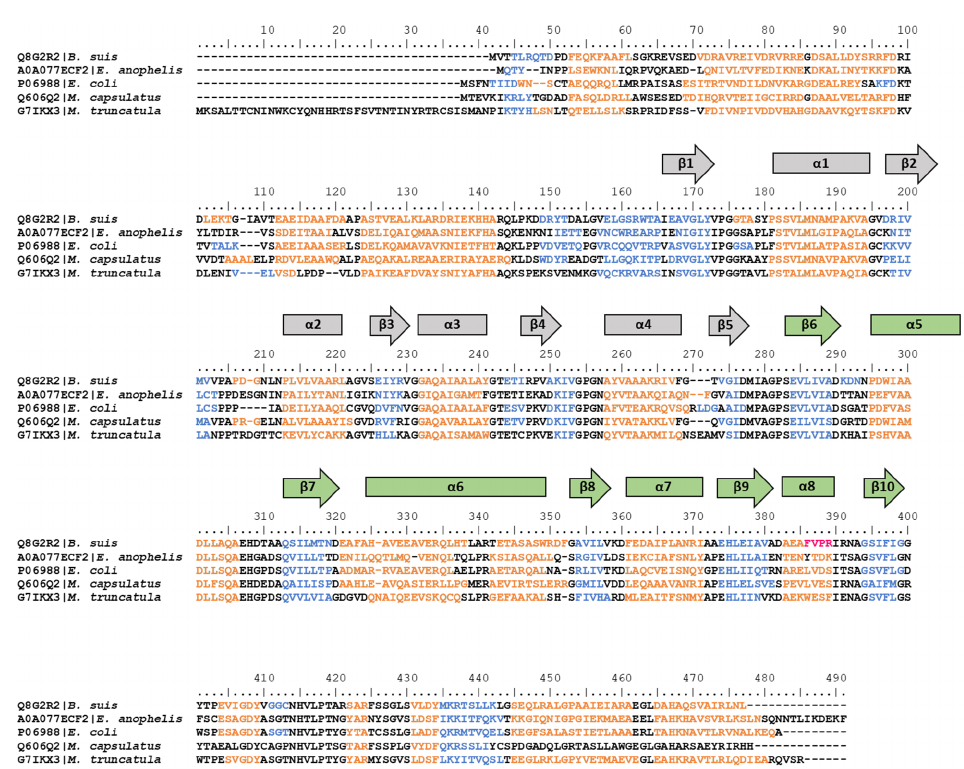
Figure 10. Alignment of the amino acid sequences of HDHs reported in the PDB. Secondary structure elements are reported in orange ( α -helices), blue ( β -strands), and fuchsia (turns). α -helices and β -strands of the two cores of the proteins are also schematized with rectangles and arrows, respectively; the elongation event is depicted with the two cores of the proteins colored in grey and green.